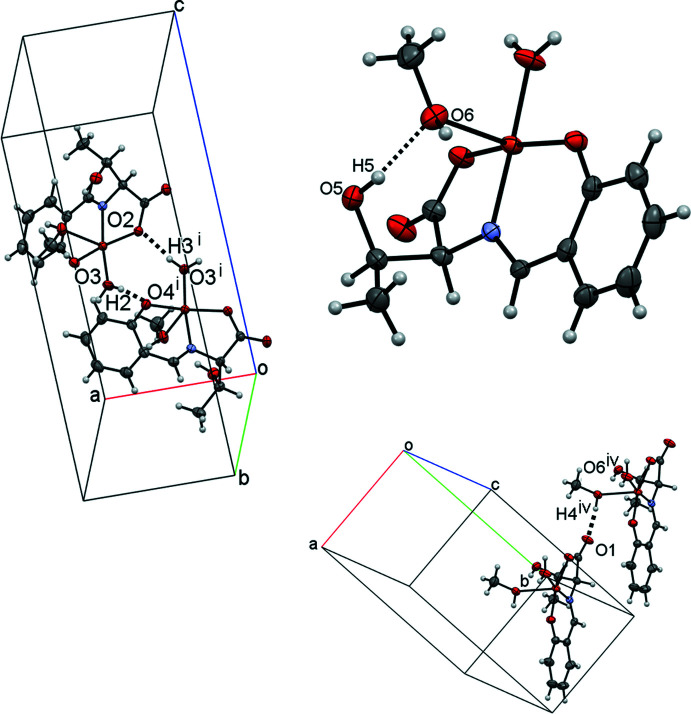
A view of the intra- and inter­molecular O—H⋯O hydrogen bonds, shown as dashed lines. [Symmetry codes: (i) x − , −y + , −z + 1; (iv) x − 1, y, z.]